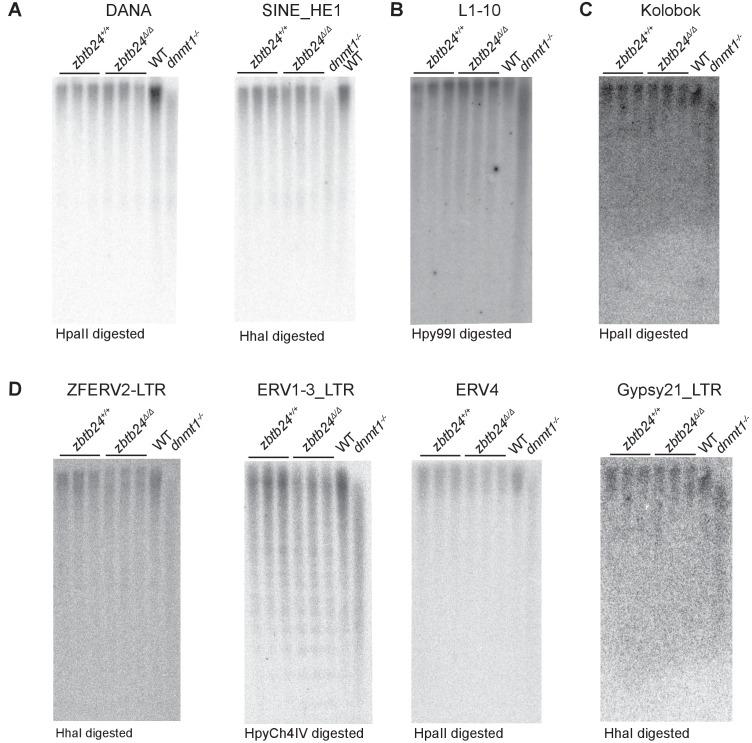
Methylation at interspersed repeats is unaffected in zbtb24 mutants.Southern blot analysis of DNA methylation at interspersed repeats (A) Short Interspersed Nuclear Element (SINE), DANA and SINE_HE1 (B) Long Interspersed Nuclear Element (LINE), L1-10 (C) DNA Transposon, Kolobok (D) Endogenous Retroviral (ERV) elements, ZFERV2, ERV1-3, ERV4 and Gypsy21 in zbtb24+/+ and zbtb24Δ/Δ 1 month old zebrafish. Each lane represents a biological replicate of the indicated genotype. Genomic DNA from dnmt1-/- embryos is used as a positive control. The methylation-sensitive enzyme used to digest genomic DNA is indicated below the respective blot.